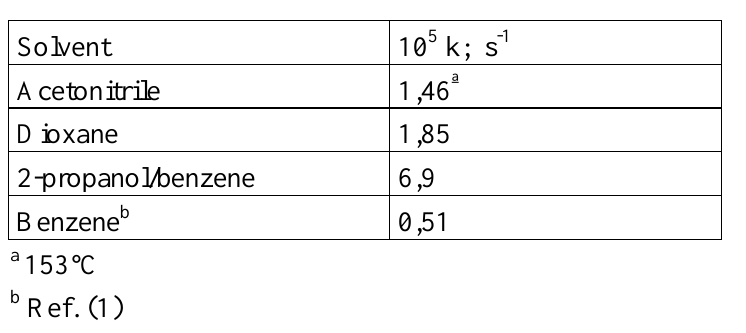
Table 1. First order rate constant values for APDP thermolysis in different solvents at